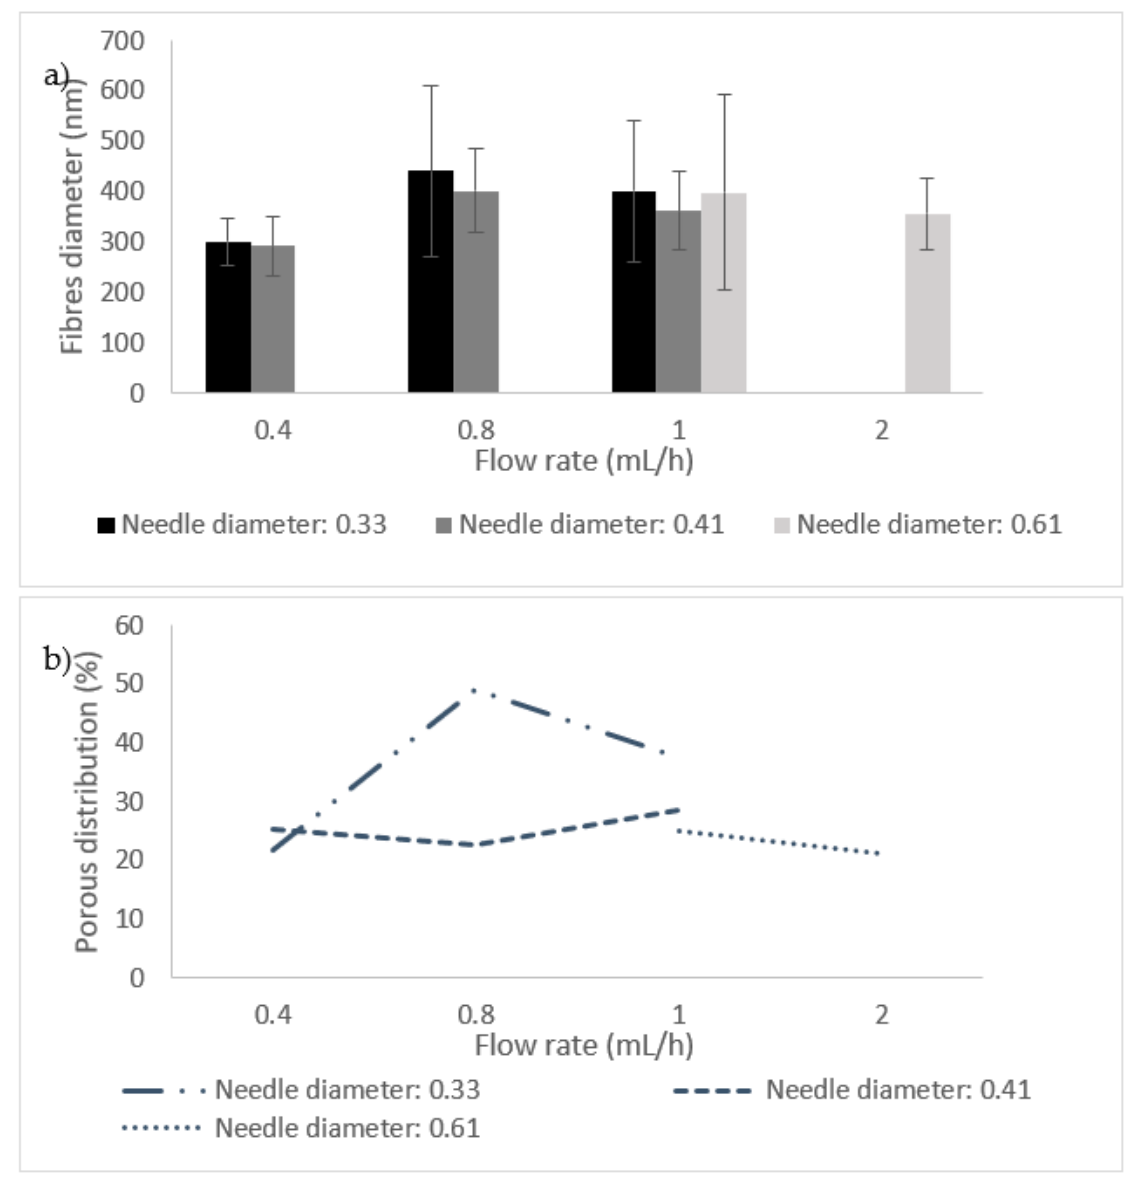
Figure 5. Influence of needle diameter ( a ) and flow rate ( b ) on fibre diameter and porous distribution values.